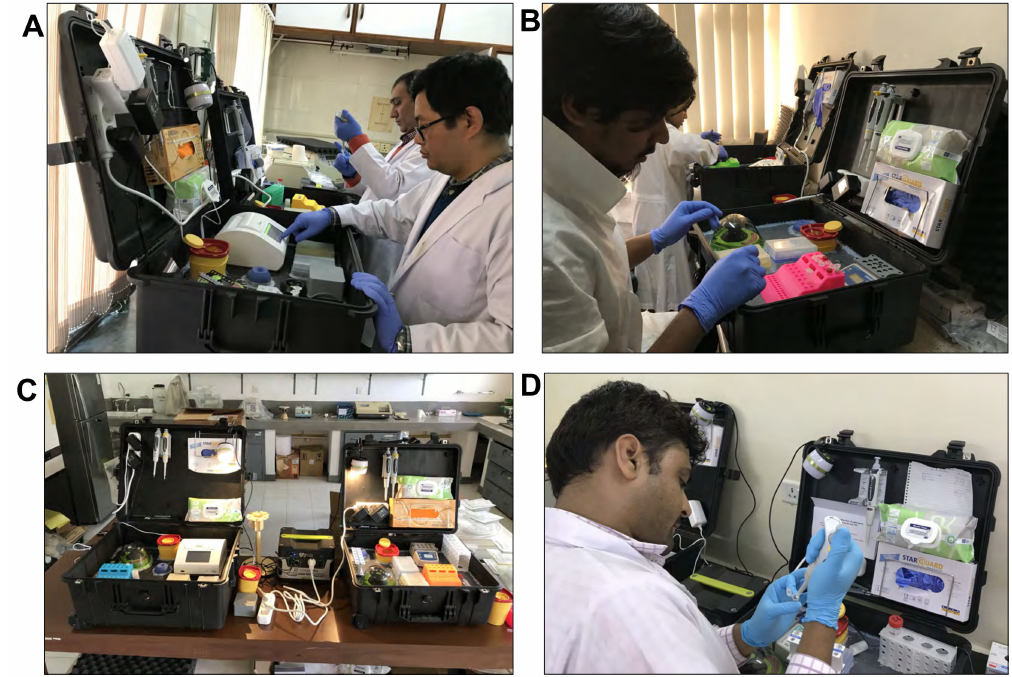
Figure 2. Deployment of the mobile suitcase lab in ( A ): B.P. Koirala Institute of Health Sciences (BPKIHS), Nepal; ( B ): International Centre for Diarrheal Disease Research, Bangladesh (icddr,b); ( C ): University of Sri Jayewardenepura (USJ), Sri Lanka and ( D ): Rajendra Memorial Research Institute of Medical Sciences (RMRI),